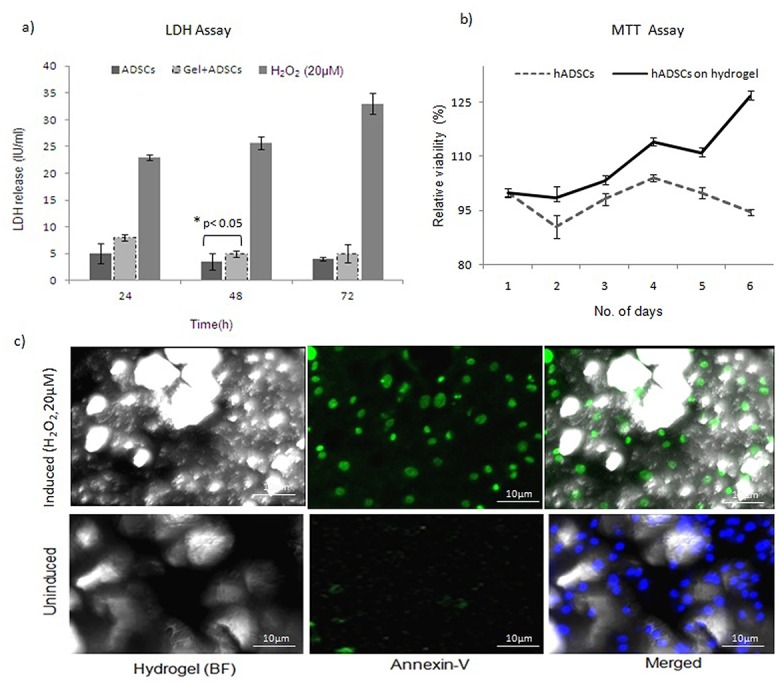
Bio-compatibility profiling of hADSCs on chitosan hydrogel.a) The results presented are the mean ± SD LDH levels detected in supernatants at different time intervals. LDH release was not detected for stem cells cultured on the hydrogel (n = 4, P <0.05). b) MTT assay was used to represent cell metabolic activity and viability of hADSCs encapsulated in chitosan matrix for 7 days (mean ± SD, n = 3). c) Apoptosis assays demonstrated that the cells did not undergo apoptosis when cultured on hydrogel. In contrast, cells induced with H2O2 underwent apoptosis (n = 3).